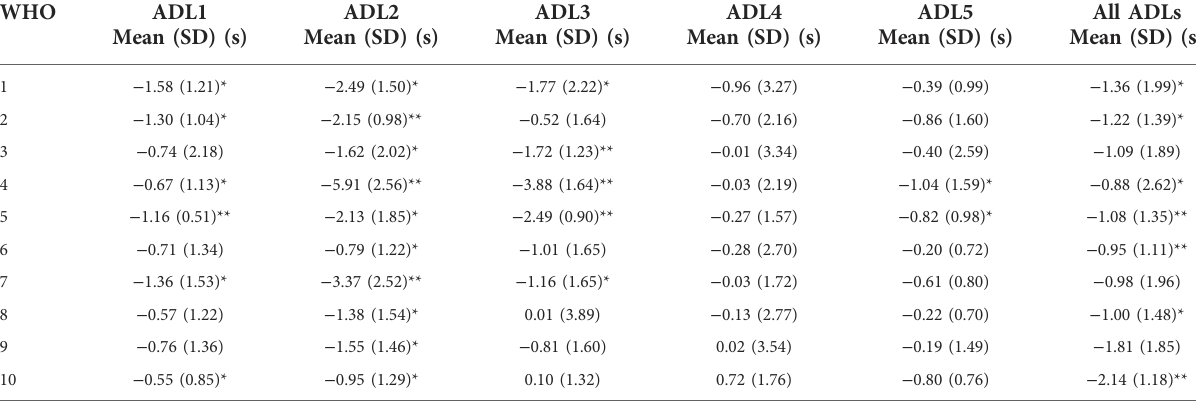
TABLE 9 Time difference (in seconds) for each ADL by WHOs calculated as with — and without WHOs. WHO ADL1 ADL2 ADL3 ADL4 ADL5 All ADLs Mean (SD)